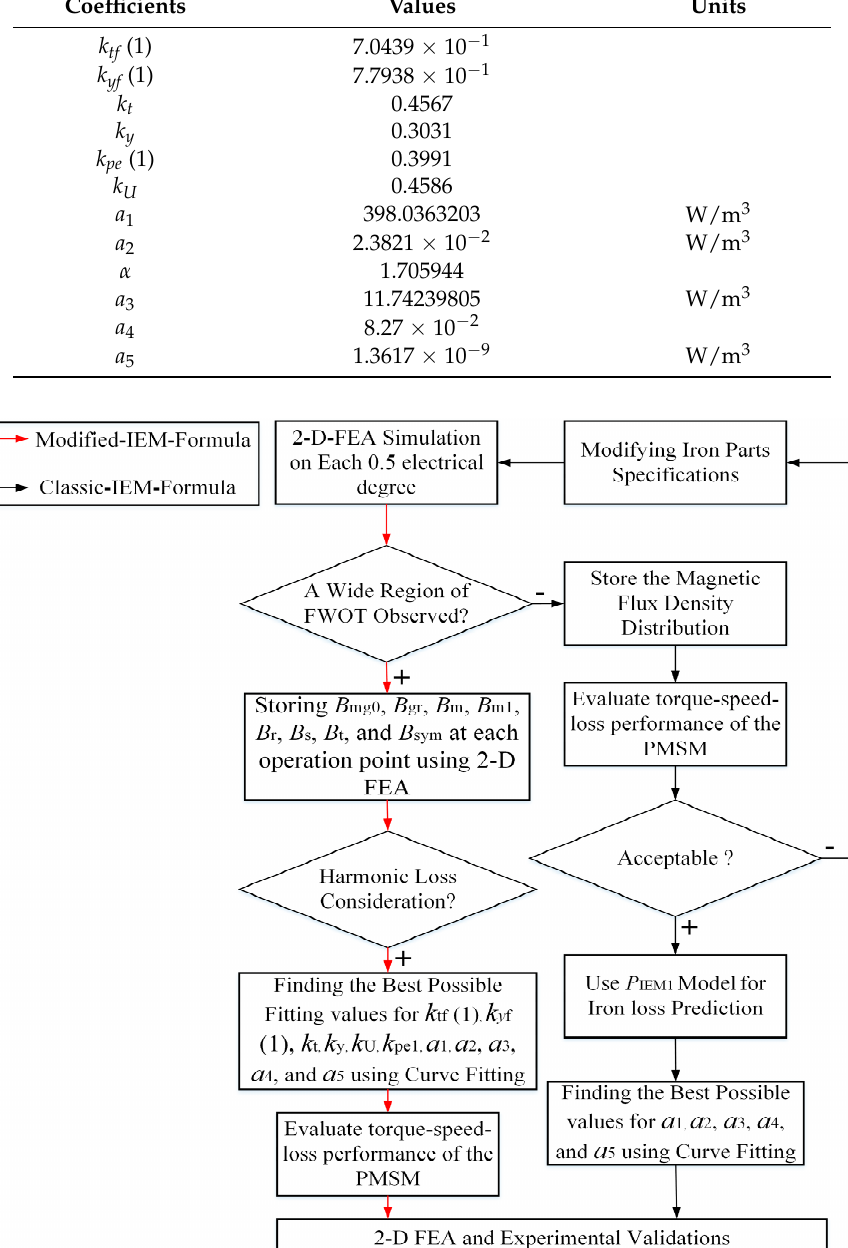
Figure 5 . Flowchart of the analysis dynamics. Figure 5. Flowchart of the analysis